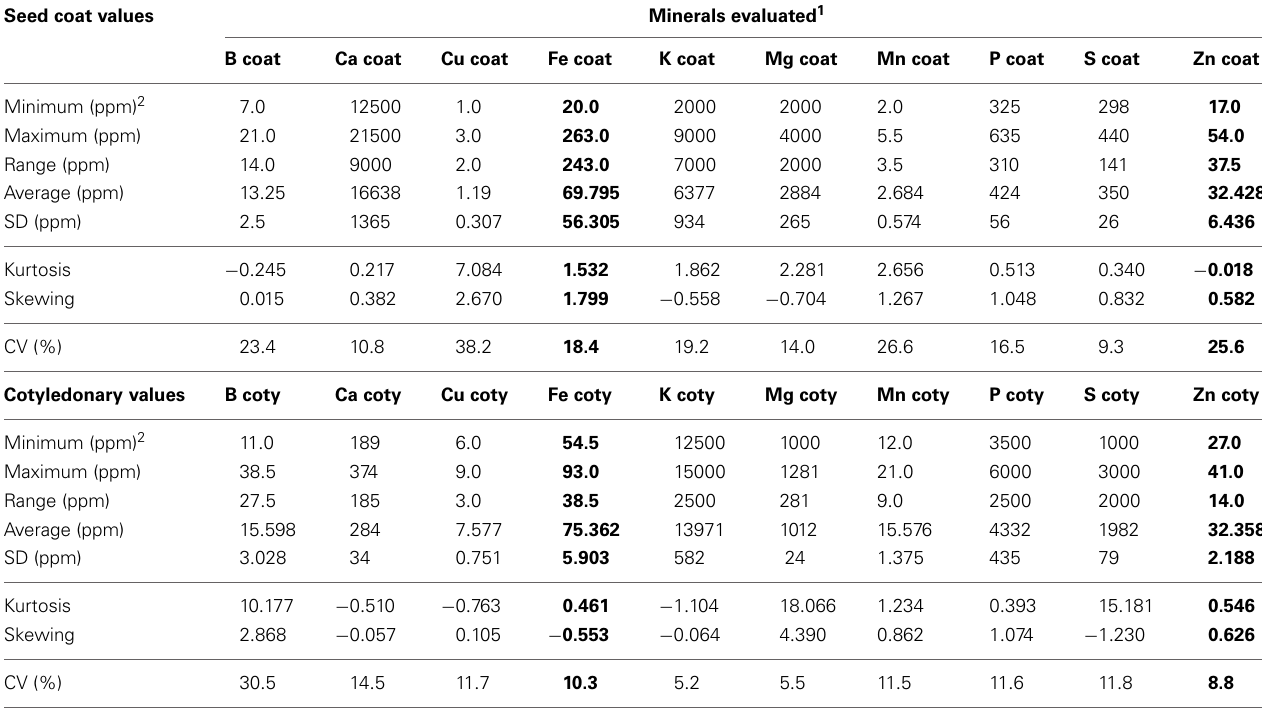
Table 1 | Descriptive statistics for seed coat vs. cotyledonary minerals evaluated as measured by inductively coupled plasma (ICP) analysis for the advanced backcross population of common